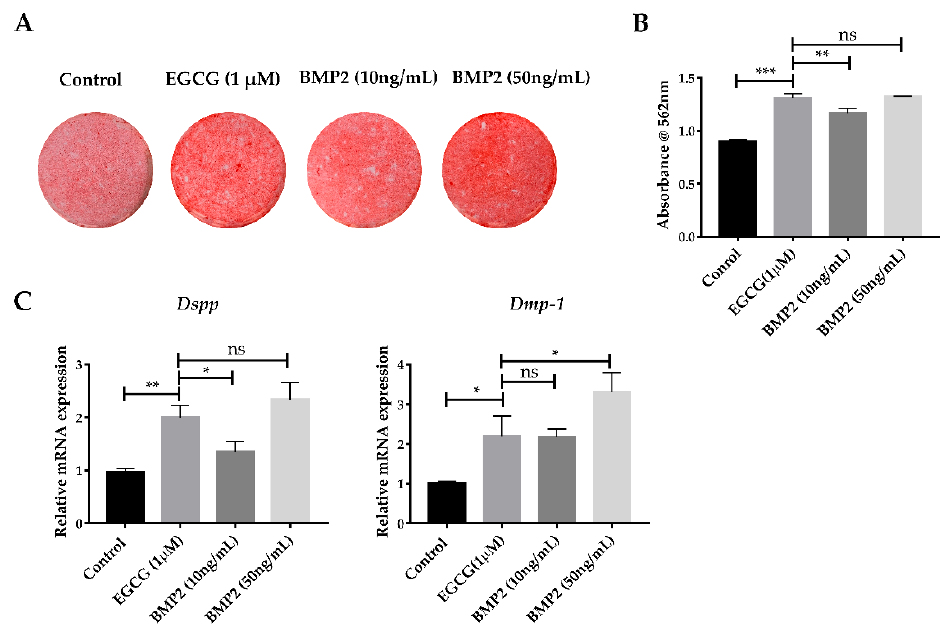
Figure 6. EGCG showed the ability to promote mineralization comparable with that of BMP2. ( A ) After 14 days of induction, the EGCG (1 µ M) group generated amounts of calcified nodules similar to the 50 ng/mL BMP2 group. ( B ) Semi-quantification of mineralized deposits. ( C ) RNA expression of Dspp and Dmp-1 at 14 days ( n = 3). Error bars: mean ± standard deviation. (* p < 0.05, ** p < 0.01, *** p < 0.001, ns: not statistically significant).